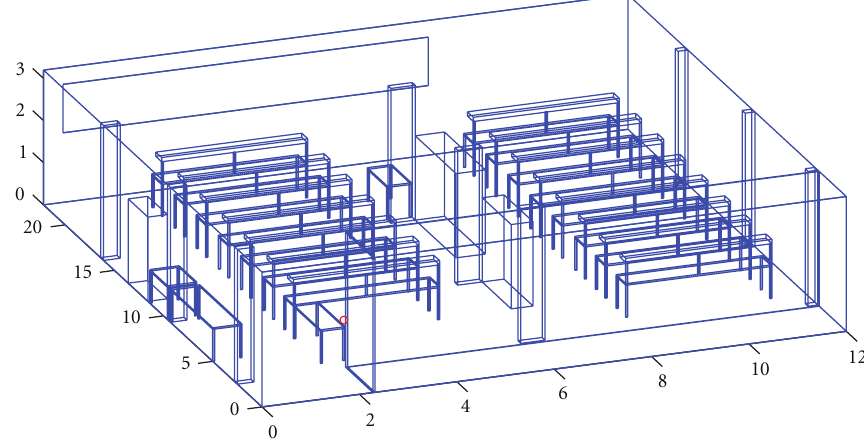
Figure 19: Scenario 2: Radio communication laboratory.